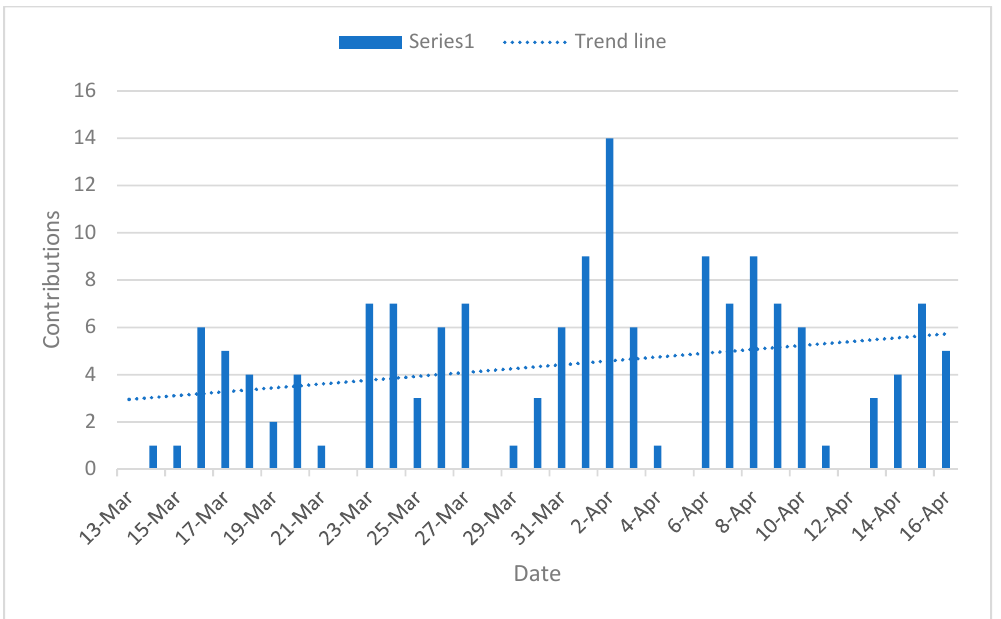
Figure 1. Contributions per day from 14 March to 16 April.